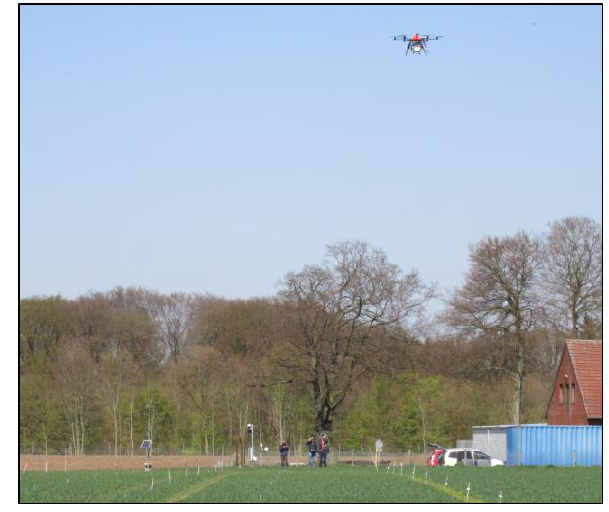
Figure 2. UAV-mounted Yara N-Sensor in